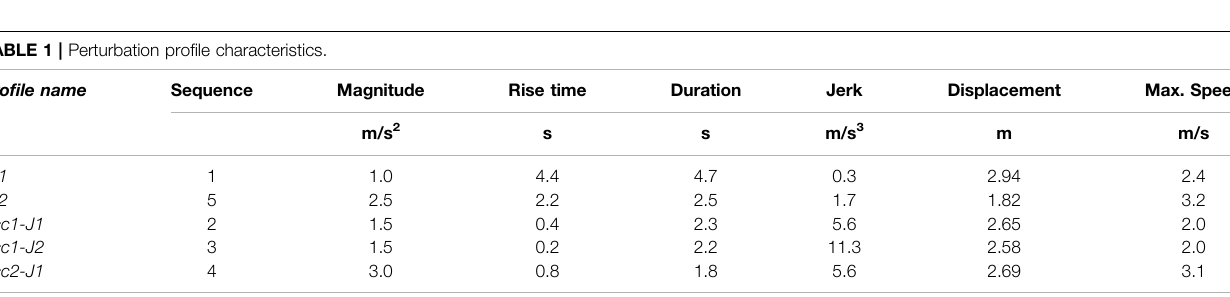
TABLE 1 | Perturbation pro fi le characteristics.